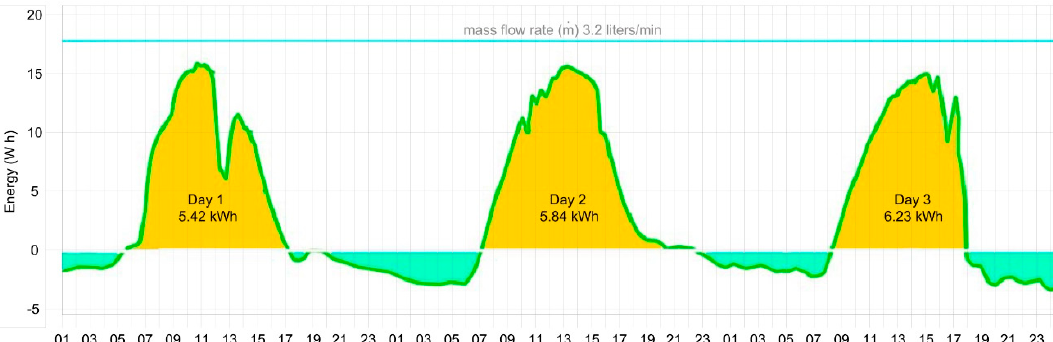
Figure 10. Energy absorbed in the horizontal glazing. Area of glazing = 3.5 m 2 ; mass flow rate = 3.2 L per minute. Sample summer days: 23–26 August. Table 2. Energy balance of the horizontal WFG.